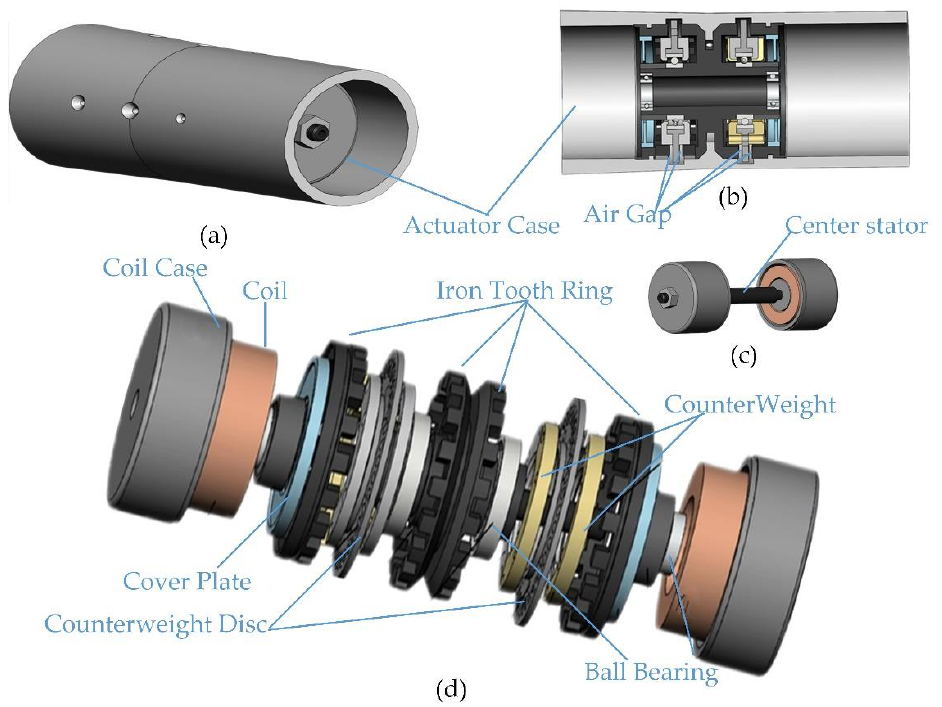
Figure 2. Three-dimensional model of the balancing actuator: ( a ) Global shape; ( b ) Rotatory part; ( c ) Stationary part; ( d ) Exploded view.